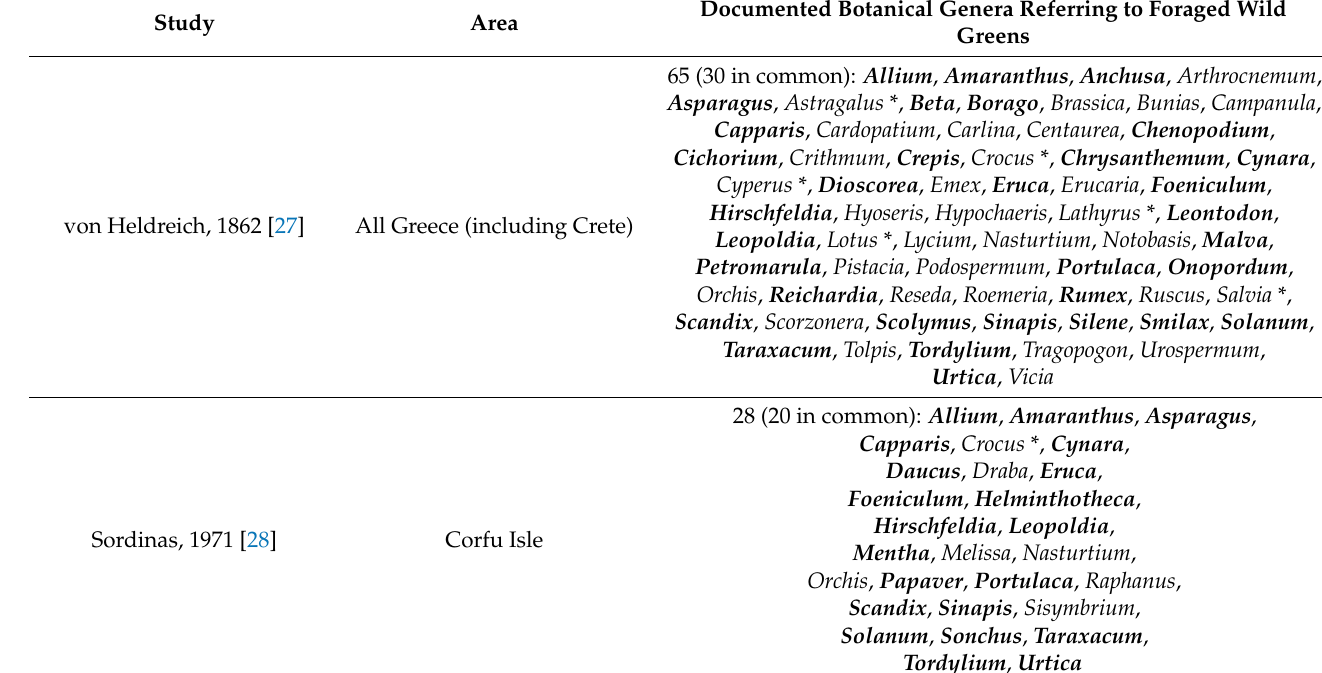
Table 3. Botanical genera of the Cretan wild greens also quoted as being consumed in Greece 50 years ago and during the 19th